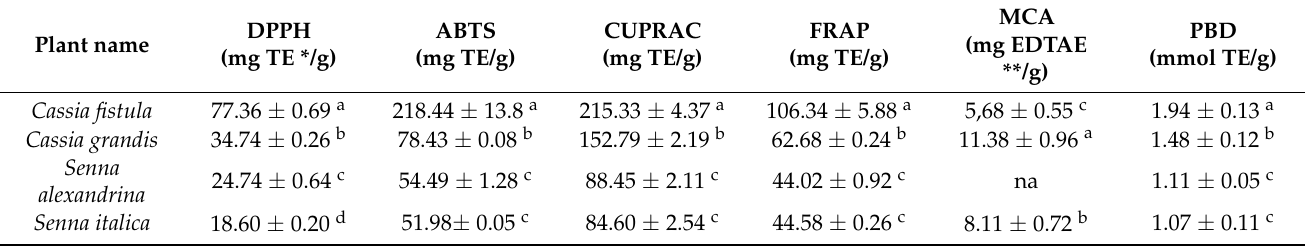
Table 3. Antioxidant activity of leaf methanolic extracts of the Cassia and Senna